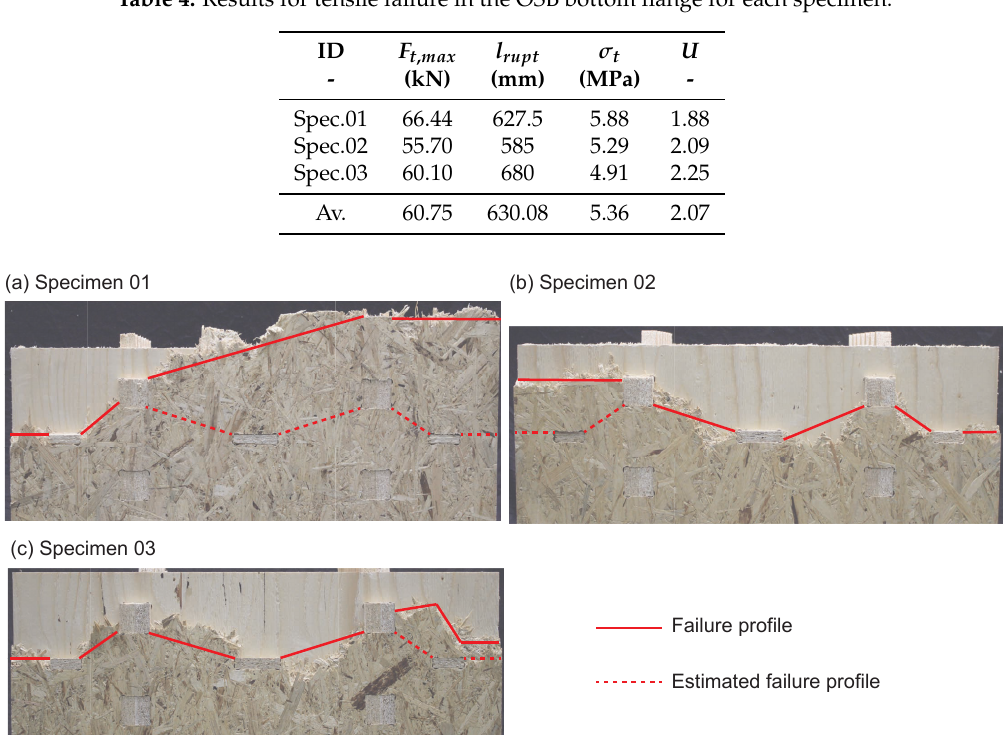
Table 4. Results for tensile failure in the OSB bottom flange for each specimen.